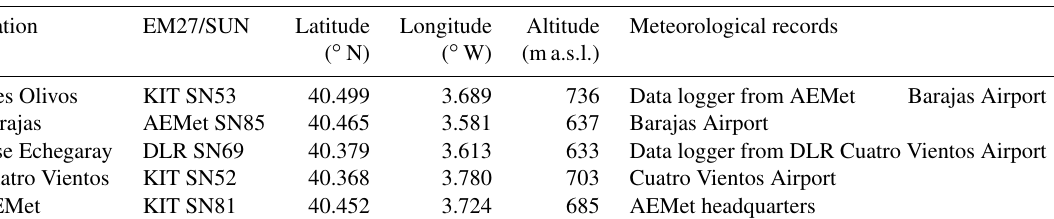
Table 1. Locations of the five COCCON instruments and meteorological records for the MEGEI-MAD field campaign during 24 September–